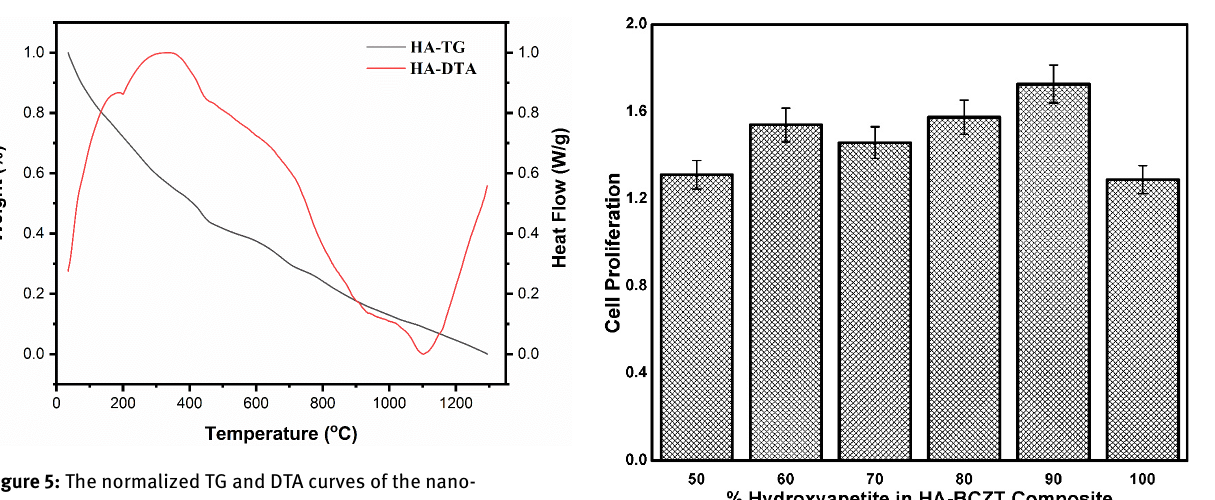
Figure 5: The normalized TG and DTA curves of the nano- hydroxyapatite powder dried at 80 ∘ C recorded at a heating rate of 10 ∘ C/min in air Figure 6: The relative cell proliferation observed for the various